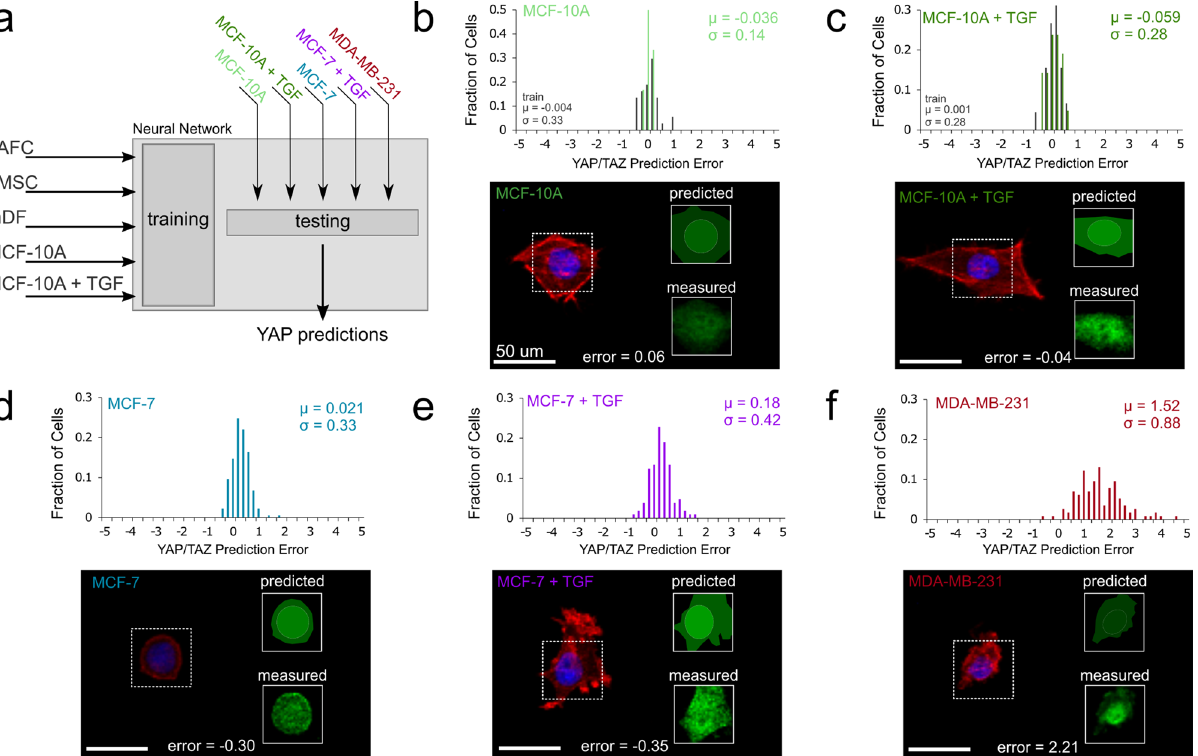
Figure 5. Non-tumorigenic breast epithelial and non-invasive breast cancer cells are predictable, while invasive breast cancer cells are not. ( a ) The neural network model was updated to include ground truth data on epithelial cells with and without TGF-β 1 to instigate epithelial-to-mesenchymal transition (EMT). ( b , c ) Non- tumorigenic breast epithelial (MCF-10A) and (d,e) non-invasive breast cancer (MCF-7) cells showed predictable morphology-mechanosensing relationships, and this predictability remained when these cells were pushed towards EMT using TGF-β 1 . (f) In contrast, invasive breast cancer cells (MDA-MB-231) showed unpredictable YAP/TAZ levels based on cell and nuclear morphology (n MCF-10A-train = 37, n MCF-10A-test = 12, n MCF-10A+TGF-train = 45,